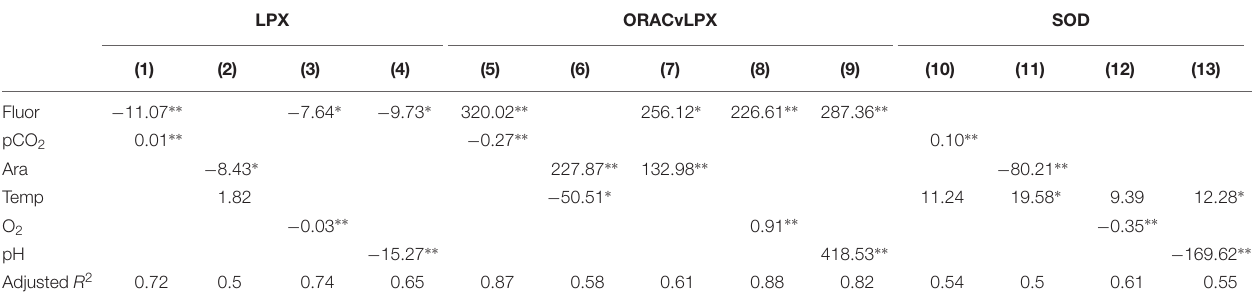
FIGURE 5 | Correlation matrix of environmental variables, with cellular, physiological, and population response endpoints for pteropods. Darker red values are strong positive correlations and darker purple values are strong negative correlations. Significance values at alpha = 0.05 are shown by stars ( p < 0.05 ∗ , p < 0.01 ∗∗ ). For oxidative biomarker abbreviations refer to Table 1 . TABLE 2 | Model results for pteropod cellular response to pairs of co-occurring environmental